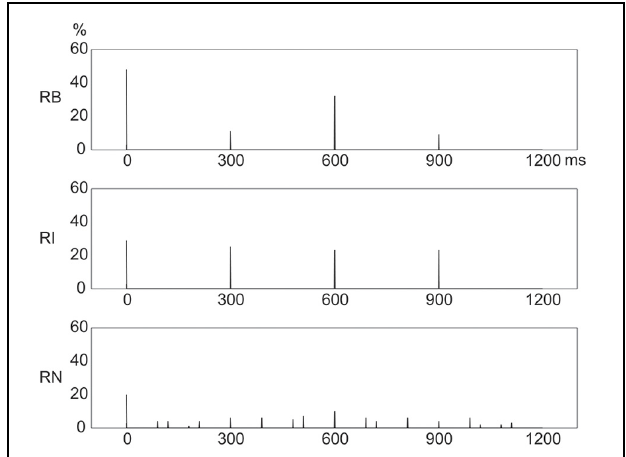
FIGURE 4 | Frequency distributions of presented events in a beat interval. The three types of rhythm had distinct frequency distributions of rhythm events. Y axis: percent of event occurrences. X axis: positions with event occurrences in a beat interval 1200ms in duration. RB, RI, and RN represent rhythms formed with binary, non-binary integer, and non-integer ratios,